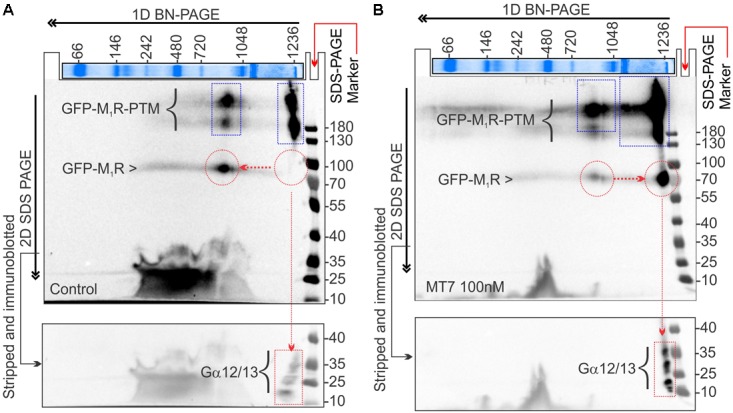
MT7 and pirenzepine elevated sequestration of trimeric G proteins in a protein complex associated with M1R in SH-SY5Y cells. (A,B) BN-PAGE analysis showing recruitment and sequestration of G proteins to M1R following MT7 treatment. GFP-M1R transfected cells were treated with 100 nM MT7 and incubated for 1 h. Cell lysates were then separated on 1D BN PAGE followed by 2D SDS-PAGE, (A) Control, (B) 100 nM MT7 treatment. Top panel: Coomassie stained gel piece showing 1D BN-PAGE separation of native page protein molecular weight marker. The red horizontal and vertical arrows indicate the direction of the 1D BN-PAGE and 2D SDS-PAGE, respectively. The blue rectangle shows PTMs of GFP-M1R associated with 1000 kDa and >1200 kDa MPCs. The red circle indicates native form of the GFP-M1R associated with the MPCs. The red arrow connecting the red circles indicates shift of molecular weight in MPC due to recruitment of G proteins following drug treatment. The red rectangle in the bottom panel shows the co-migration of possible interacting G proteins with the MPCs.